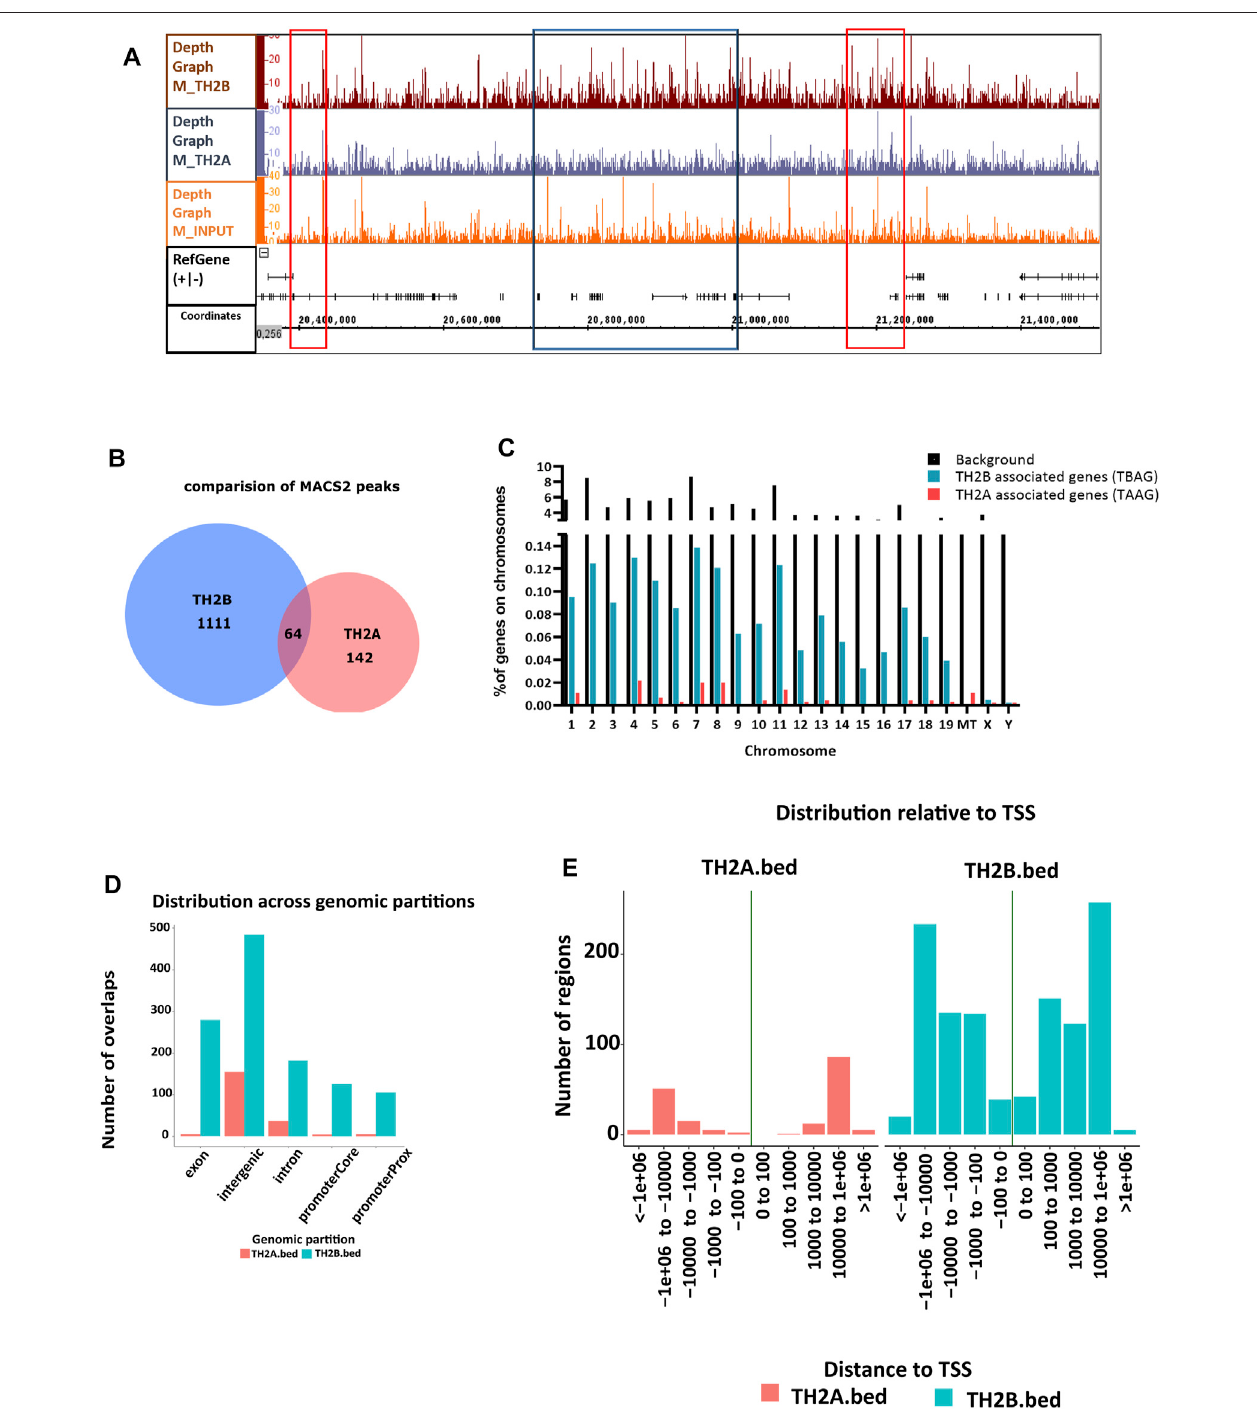
FIGURE4| Genome-widedistributionofTH2AandTH2Binsperm. (A) IntegratedGenomeBrowserviewofrelativecoverageforchromosome1(mm10)asshown bydepthgraphusingsortedBAM fi lesforTH2A,TH2B,andInput.TheredboxdepictsregionsofsimilaritybetweenTH2AandTH2Bpro fi leswhiletheblueboxdenotes thedifferences. (B) VenndiagramshowingthecommonanduniqueMACSpeaksbetweenTH2AandTH2B. (C) Barchartdescribingthepercentageofgeneoccupancy perchromosomeforTH2A(redbars)-andTH2B(bluebars)-associatedgeneswithrespecttototalgenesonthatchromosome,background(blackbars). (D) TH2A and TH2B distribution across genomic partitions. (E) Relative distance of TH2B and TH2A MACS2 peaks from the transcription start site (TSS).